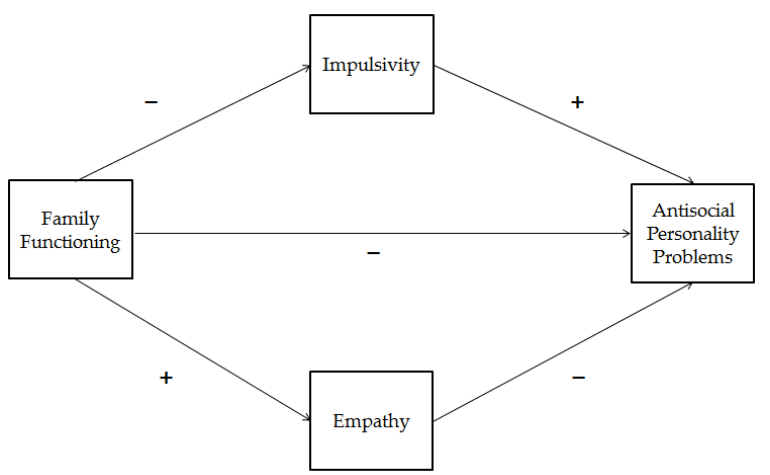
Figure 1. Conceptual model. + indicates positive statistical relationships; – indicates negative statistical relationships.